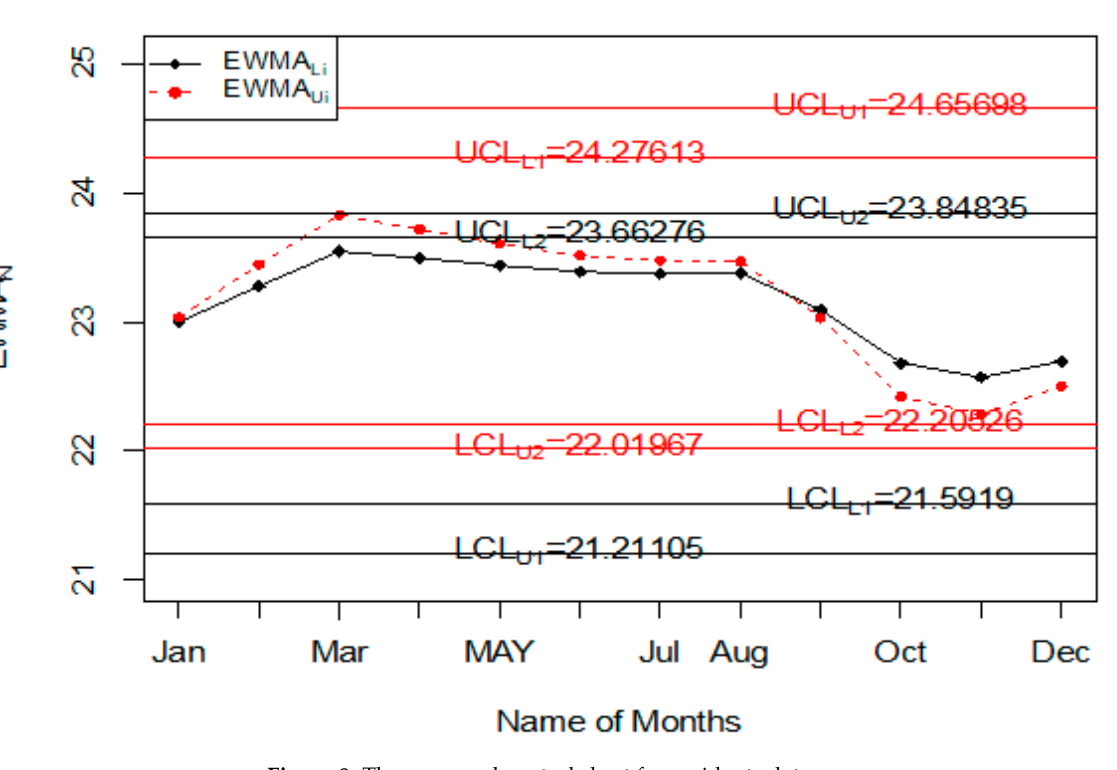
Figure 8. The proposed control chart for accidents data.